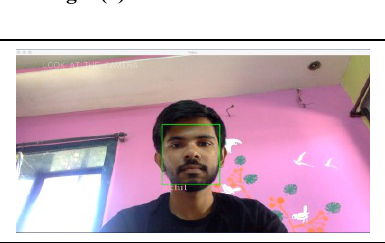
Fig. 5(a) : Test case1 with Glasses